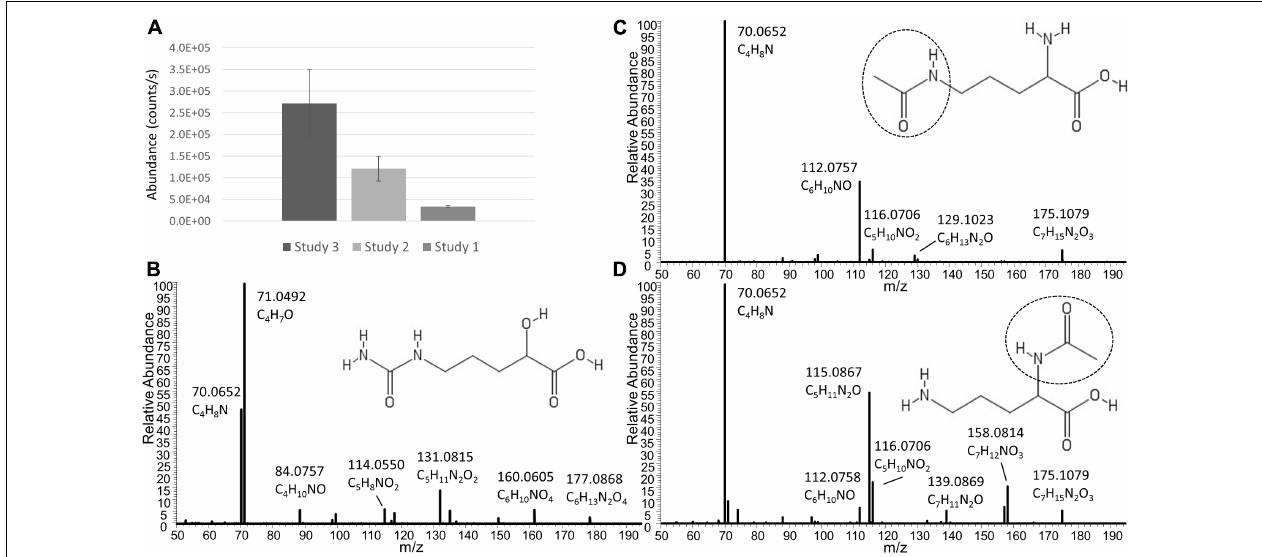
FIGURE 4 | (A) Average levels (counts/s) of a metabolite released only by Nissle in three independent experiments (Studies 1, 2, and 3). Note that the absolute levels are dependent on many factors such as column bleeding, matrix effects, co-elution of metabolites, amongst others. The metabolite was not detected in any other strain investigated. The elemental formula of C 6 H 12 N 2 O 4 and its fragmentation spectrum shown in (B) indicate its relatness to Citrulline and Arginic acid. Via use of MAGMa (see Supplementary Figure S3) and manual inspection of the MS/MS spectrum, the structural annotation of 5-(Carbamoylamino)-2-hydroxypentanoic acid was established. Panel (C) shows the Nissle LC-MS/MS spectrum of N5-acetylornithine which was released by Nissle, CFT073, and NCTC12241/ATCC25922. Note the absence of the NH 3 loss in this spectrum. Other strains in the study released N2-acetylornithine (spectrum shown in (D) obtained from MG1655) or no acetylornithine at all. Note the presence of the NH 3 loss, indicative for the presence of an amine group not directly next to a carboxylic acid group. Spectrum D also matched to reference spectra in the Metlin database. There was 0.4 min RT difference between the two N-acetylornithine isomers in the gradient used – with the N5 isomer eluting